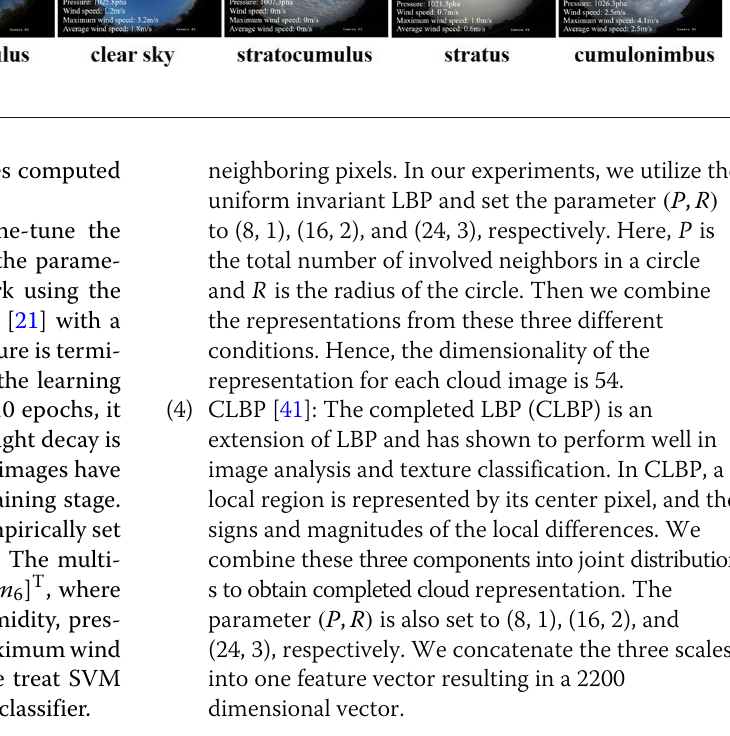
Fig. 3 The cloud samples on the MGC dataset